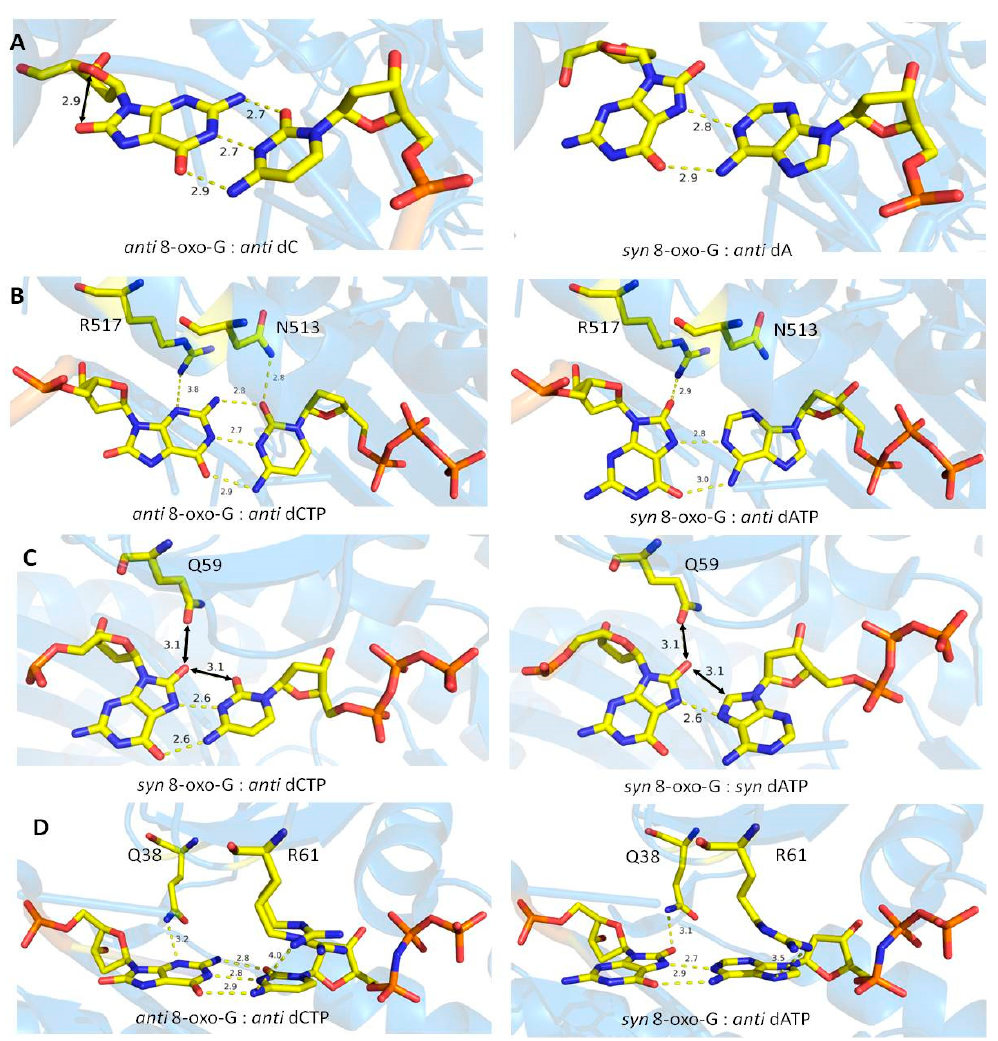
Figure 2. Interactions between the templating oxoG and incoming nucleotides in the active sites of different DNA polymerases. ( A ) Post-insertion complexes of G. stearothermophilus Pol I with the templating oxoG paired with dC (1U47) or dA (1U49) [69], ( B ) pre-insertion complexes of human Pol λ with the templating oxoG paired with dCTP (5III) and dATP (5IIJ) [71], ( C ) pre-insertion complexes of human Pol ι with the templating oxoG paired with dCTP (3Q8P) and dATP (3Q8Q) [72], ( D ) pre-insertion complexes of human Pol η with the templating oxoG paired with dCTP (4O3P) and dATP (4O3O) [73]. The database accession numbers are shown near each pair. The conformation of each nucleotide and the type of interactions are indicated: WC, Watson–Crick; HG, Hoogsteen. Atoms are colored as following: C (yellow), N (blue), O (red), P (orange). Yellow dashed lines indicate H-bonds between nucleobases or interaction with the enzyme amino acid. Double arrowed solid lines represent repulsive interactions. The distances (Å) are indicated.